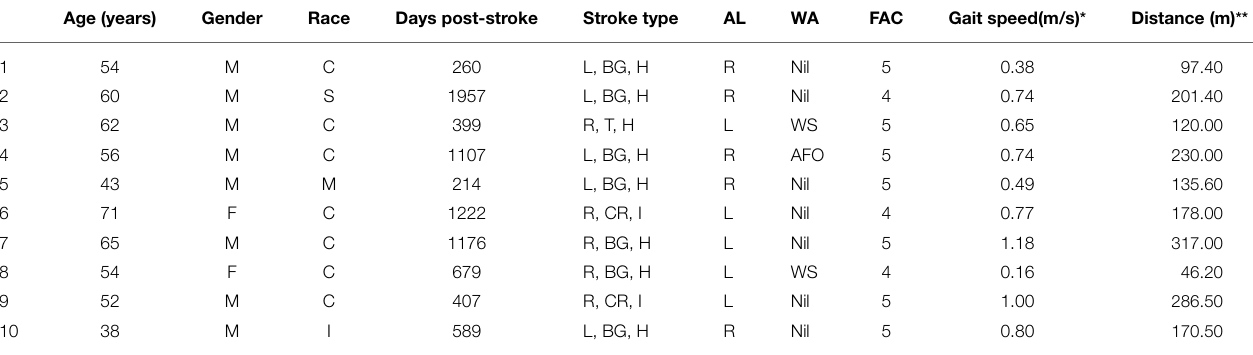
TABLE 1 | Baseline characteristics of subjects ( n = 10